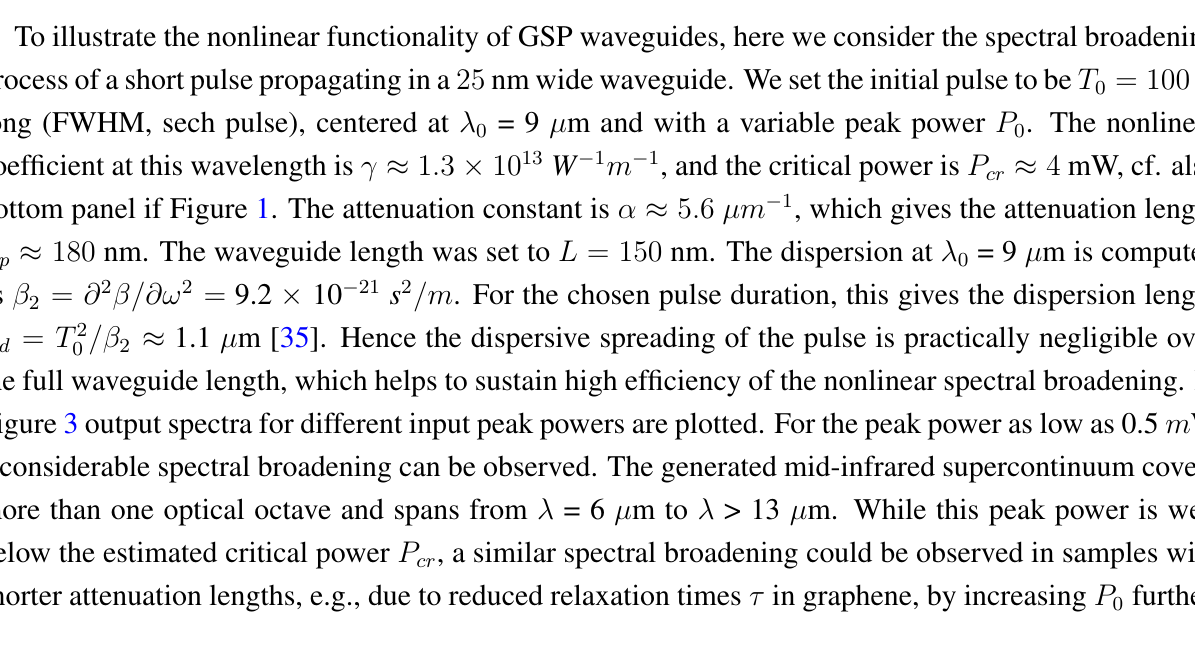
Figure 3. Numerically computed output spectra for propagation of a 100 fs sech pulse with the peak power P in the 25 nm wide and 150 nm long GSP 0